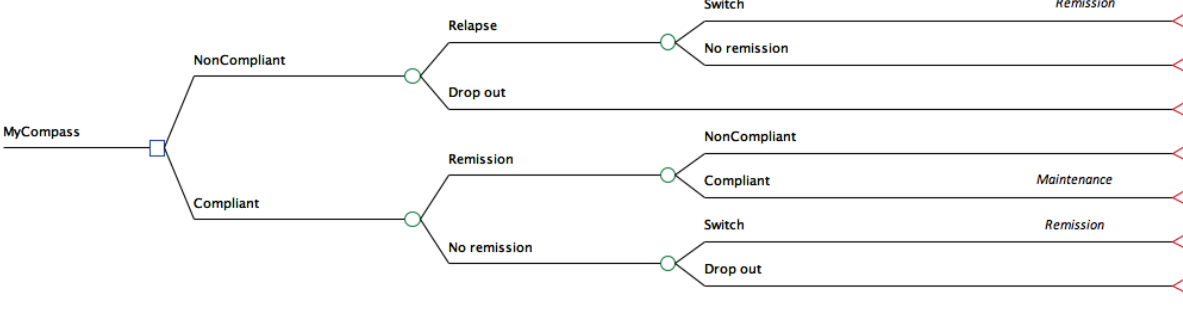
Figure 1. Partial decision tree structure (subtree is repeated for each arm of the